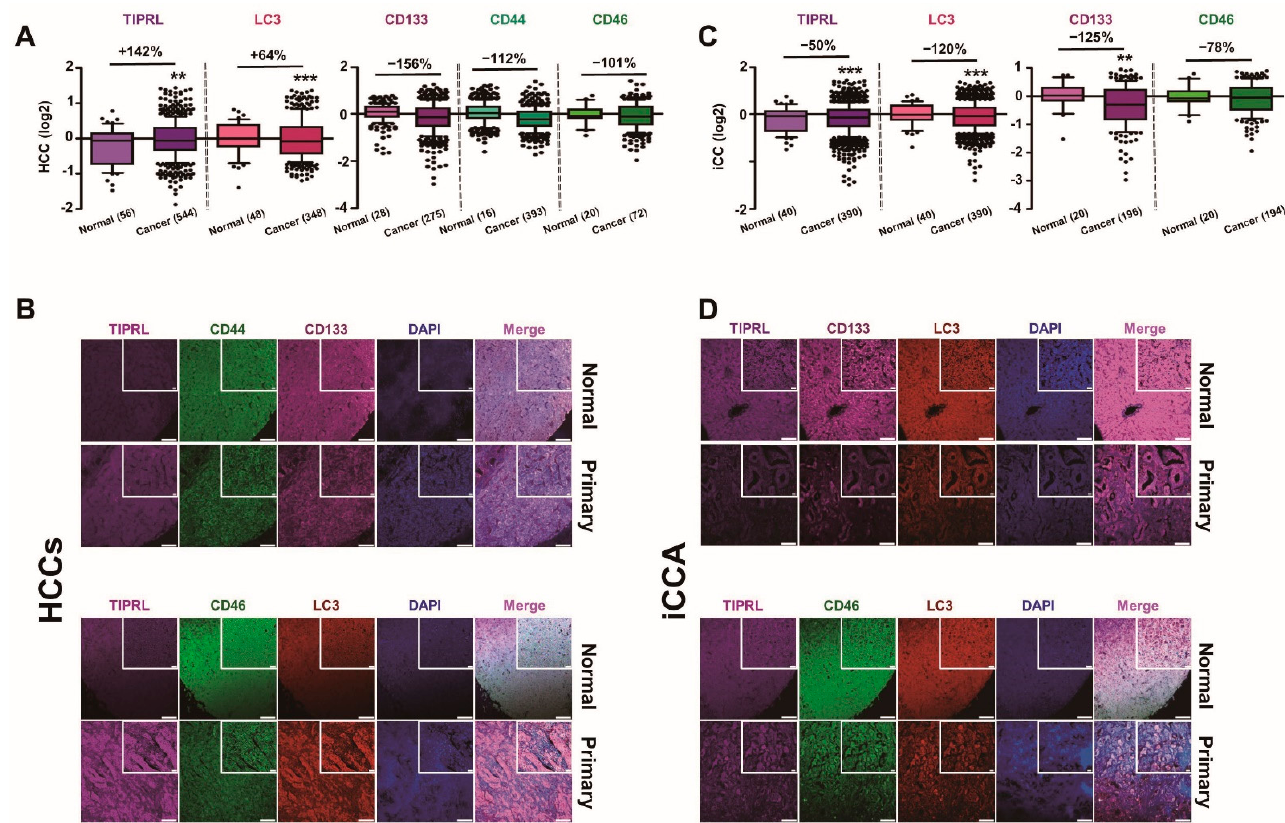
Figure 1. Differential expression of all five variables, depending on liver cancer cell types. Human liver cancer tissues were stained with the indicated antibodies followed by confocal observation. ( A , C ) The levels of all five variables were obtained using the ZEN program, and then global normalization was carried out (Tables S2 and S3). p -values (** p < 0.01; *** p < 0.001) were determined by a paired t -test, and % differences are shown. ( n ) is the number of samples. ( B , D ) The images represent normal and HCCs ( B )/iCCA ( D ), respectively. DAPI was used for nucleus staining, and scar bars, 20 μ m (inserted), and 100 μ m.